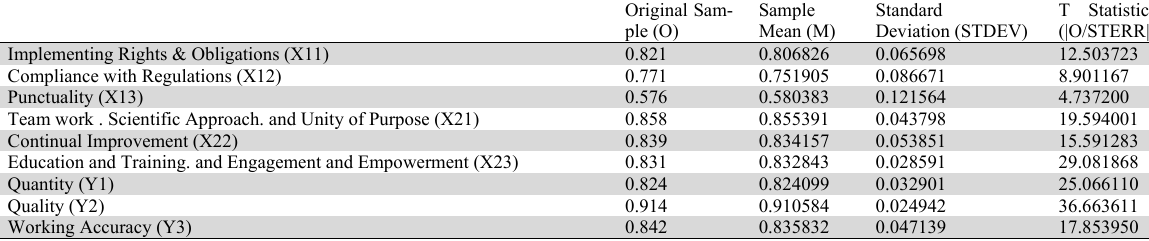
Outher Loadings (Mean, STDEV,